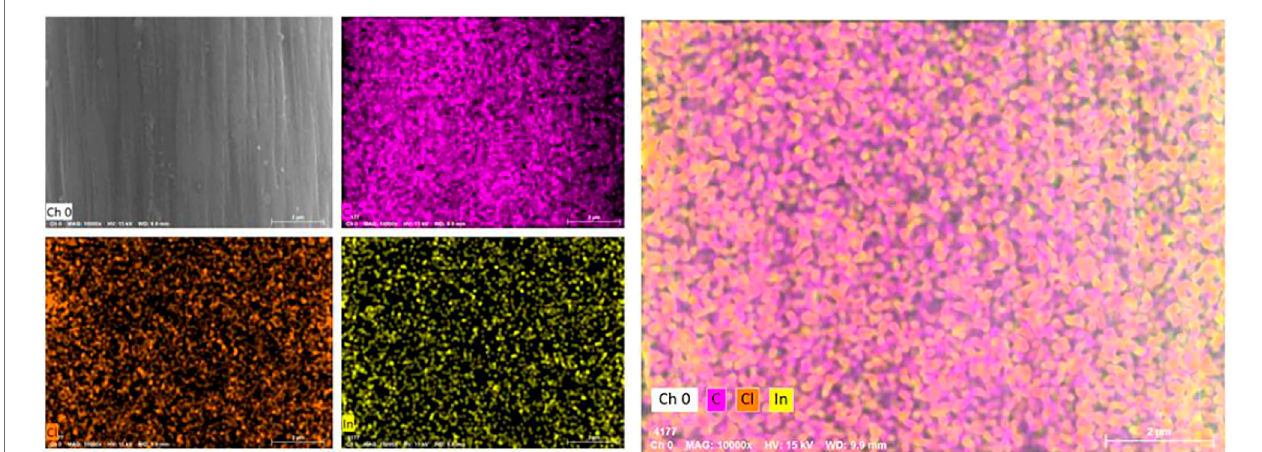
FIGURE 3 | EDS analysis diagram of heat-treated graphite felt after immersion in InCl 3 solution.